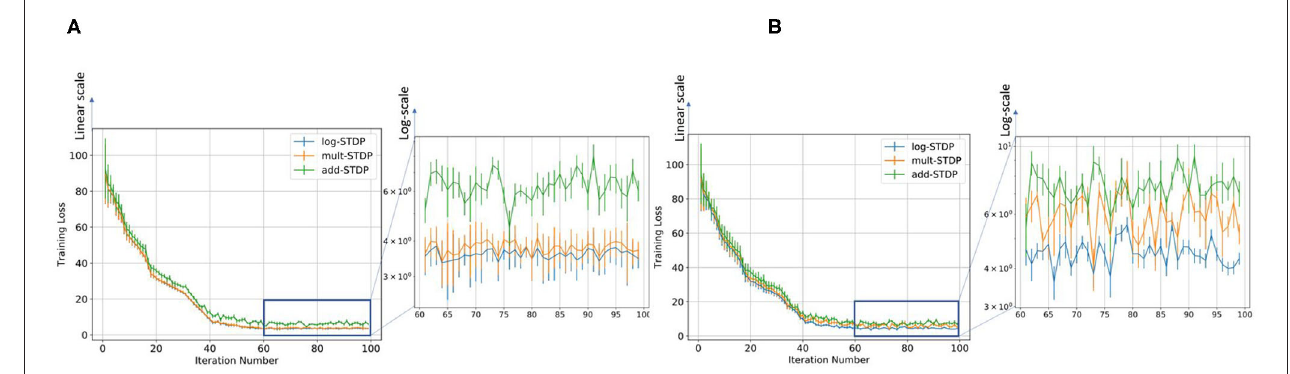
FIGURE 6 | Figure showing the variation in the training loss with increasing iterations for different types of STDP models keeping (A) SFR= 0.9 and (B) η